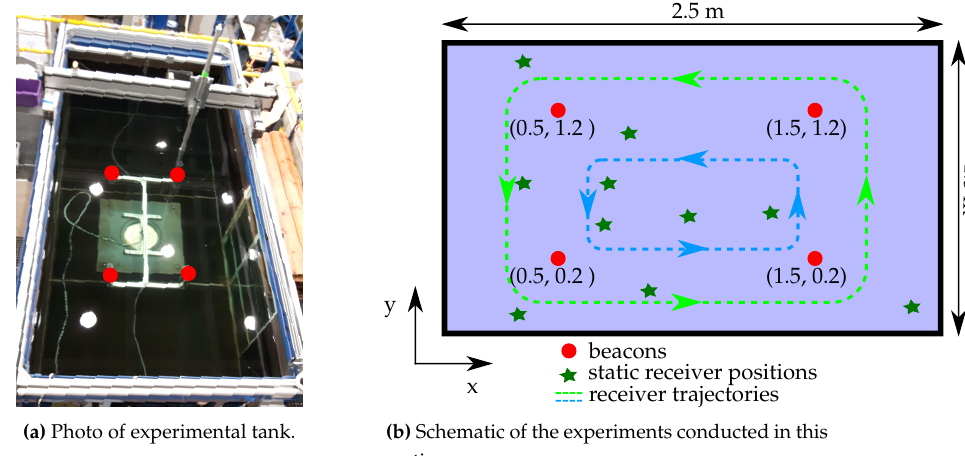
Figure 14. Experimental setup to validate the embedded EM localization system.